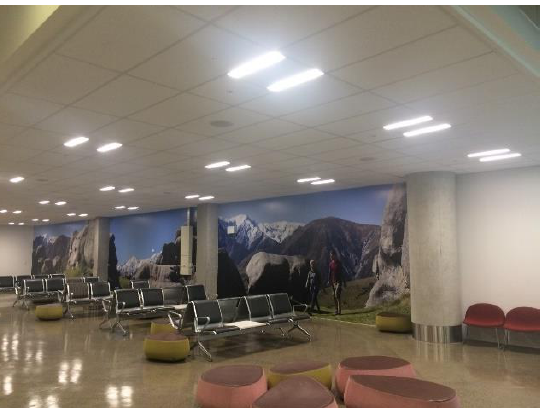
Figure 1. Visual discomfort glare of luminaires installed in the ceiling in a closed